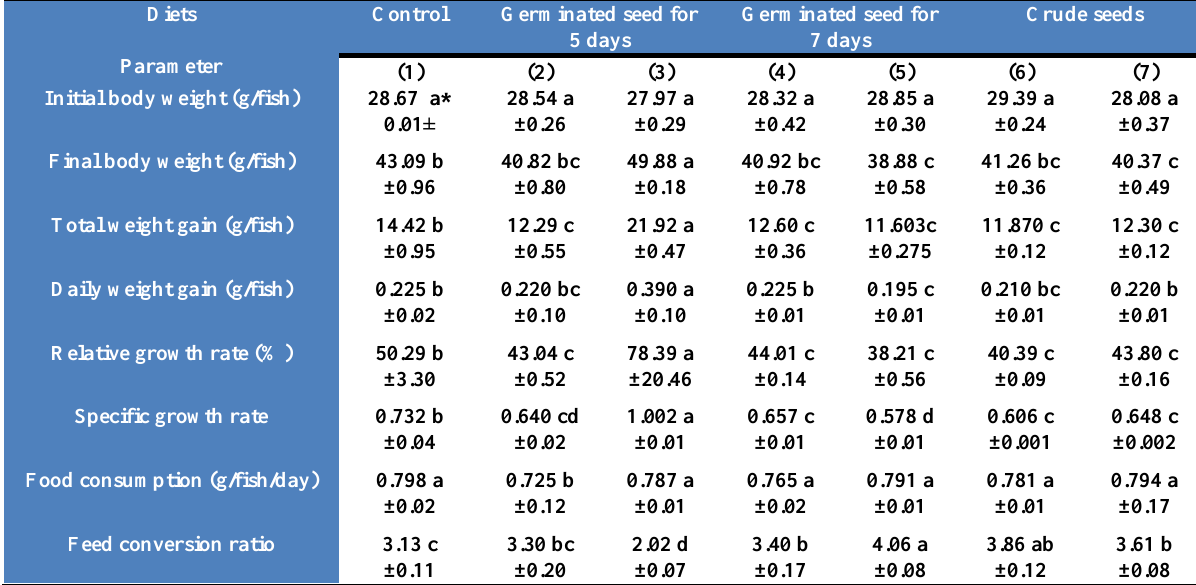
Table, 3: The effect of germinated common vetch Vicia sativa seeds for 5 and 7 days on final weight, total